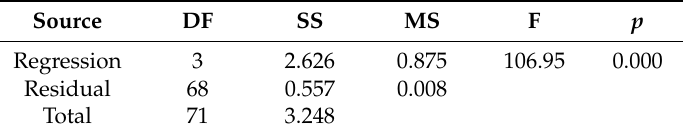
Table 4. Variance data for fitting Equation